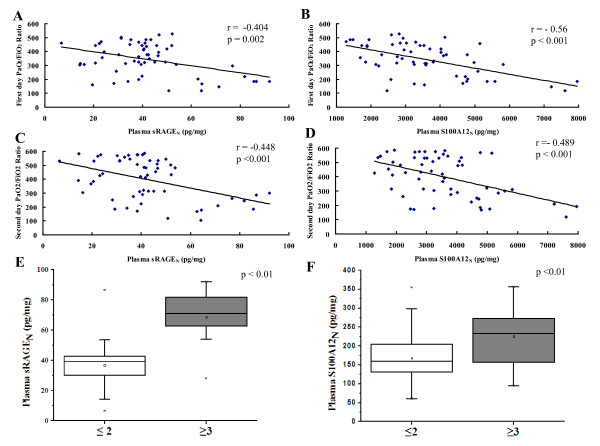
Plasma sRAGEN and S100A12N levels immediately after CPB reflecting the PaO2/FiO2 ratio (A-D) and radiographic LIS (E, F). LIS, lung-injury score.